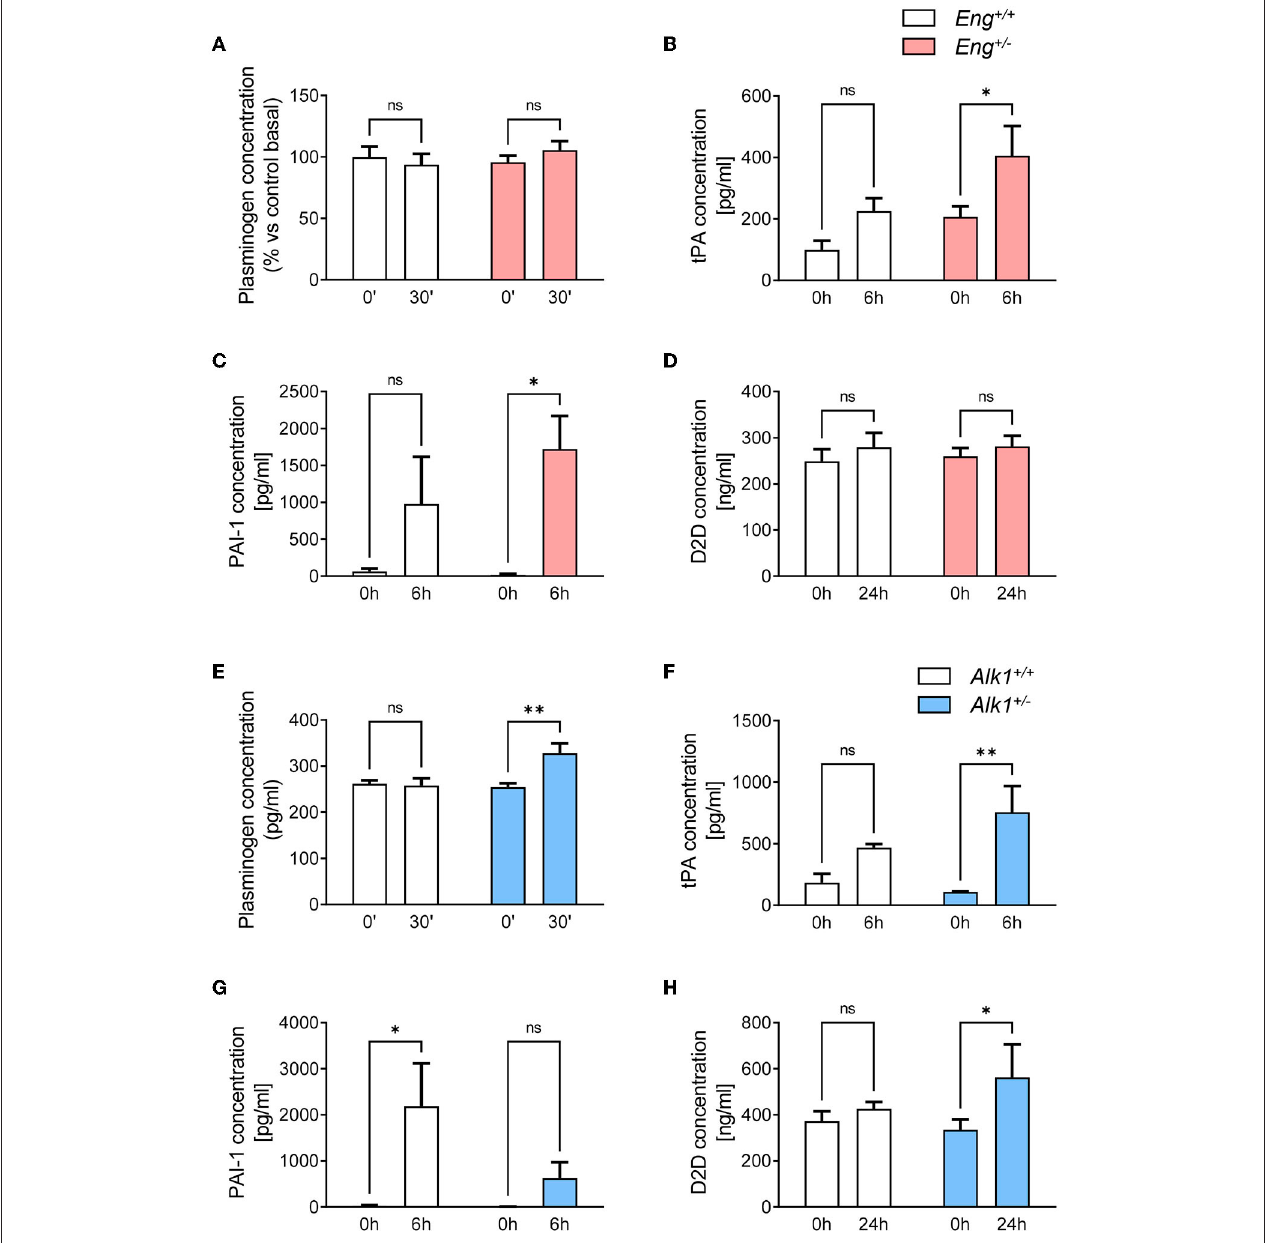
FIGURE 6 | (A) Plasma levels of plasminogen at baseline and 30min after a thrombogenic event in Eng + / + ( n = 5) and Eng + / − ( n = 5) mice. (B) Plasma levels of t-PA at baseline and 6h after a thrombogenic event in Eng + / + ( n = 5) and Eng + / − ( n = 5) mice. (C) Plasma levels of PAI-1 at baseline and 6h after a thrombogenic event in Eng + / + ( n = 5) and Eng + / − ( n = 5) mice. (D) Plasma levels of D-dimer at baseline and 24h after a thrombogenic event in Eng + / + ( n = 5) and Eng + / − ( n = 5) mice. (E) Plasma levels of plasminogen at baseline and 30min after a thrombogenic event in Alk1 + / + ( n = 5) and Alk1 + / − ( n = 5) mice. (F) Plasma levels of t-PA at baseline and 6h after a thrombogenic event in Alk1 + / + ( n = 5) and Alk1 + / − ( n = 5) mice. (G) Plasma levels of PAI-1 at baseline and 6h after a thrombogenic event in Alk1 + / + ( n = 5) and Alk1 + / − ( n = 5) mice. (H) Plasma levels of D-dimer at baseline and 24h after a thrombogenic event in Alk1 + / + ( n = 5) and Alk1 + / − ( n = 5) mice. Results were considered statistically significant if p < 0.05 (ns: non-significant; *: p < 0.05; **: p < 0.01; ***: p < 0.001; ****: p < 0.0001). thrombus formation in the mouse model overexpressing human determined as the reduction of carotid blood flow to < 5% of endoglin ( ENG + ). We found that wound closure was significantly baseline blood flow, was delayed in Eng + / − compared to WT faster in ENG + mice, which present constitutively increased mice ( Figures 5A,B ). This is in agreement with the above results levels of endoglin, than in control animals ( Figures 5C,D on platelet adhesion to the endothelium. In order to further assess the role of endoglin in these hemostasis functions, we analyzed